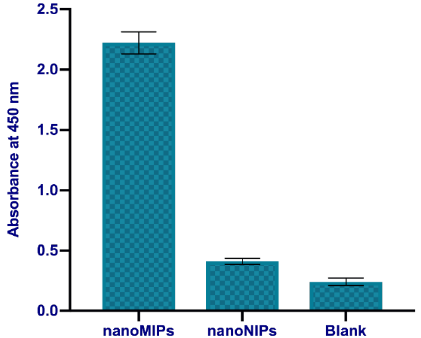
Figure 3. Binding of the horseradish peroxidase-octopamine (HRP-O) conjugate to the nanoMIPs immobilised in a microplate and uncoated microplates. Error bars represent the standard deviation for experiments performed in